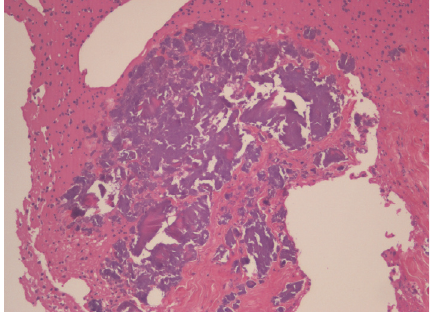
Figure 5: Coarse calcification in the cerebral parenchyma (H & E, ∗